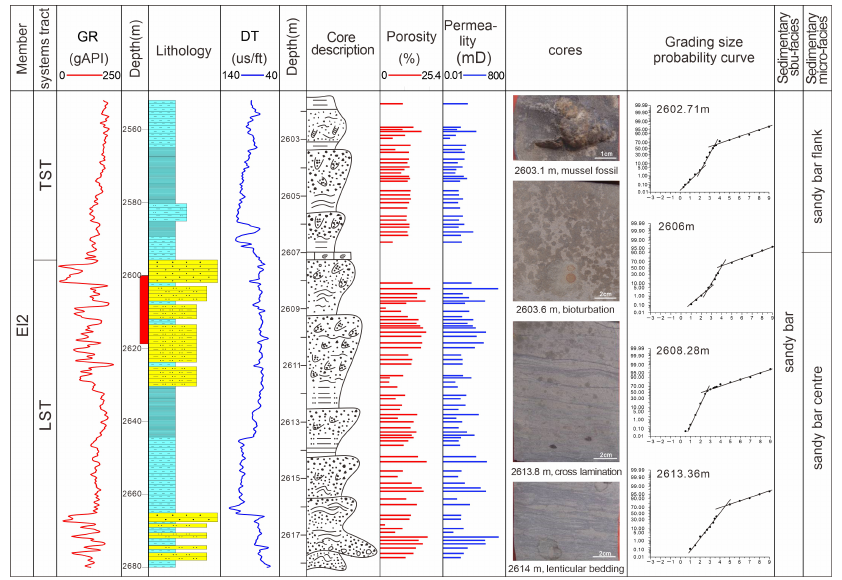
Figure 4. Single well integrated diagram of the beach-bar sand bodies of well W5 in the Weixinan sag. The red rectangle emphasized on the left logging lithologic column refers to the core description in the